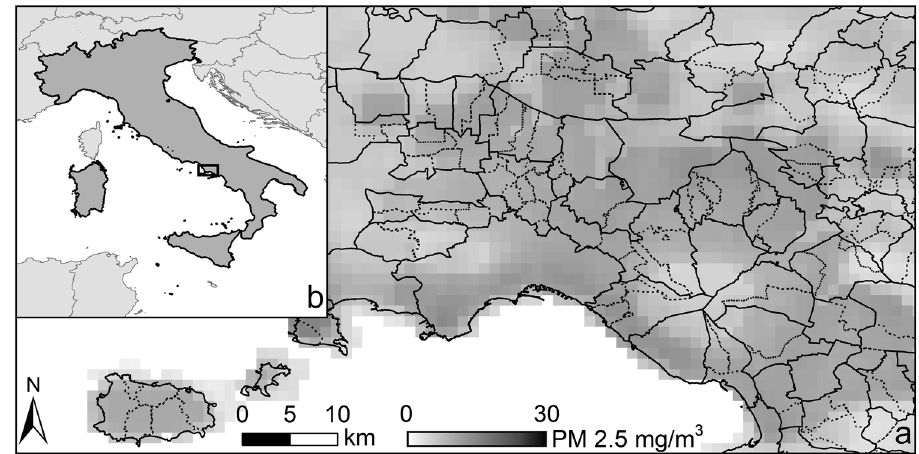
Figure 3. PM2.5 raster layer summarization by Italian communes. ( a ) A detail in the area of Naples allows to observe the impact of ‘smart dissolving’ small communes: the raster grid (grey scale) represents the PM2.5 concentration for each 0.01 degree pixels. The solid line is the results of dissolving the Italian communes using the proposed aggregation approach and by imposing an MMU of 16 km 2 . Dashed line shows the original communes boundaries. ( b ) The location (rectangle) of the area represented with ( a ) in the Italian peninsula. Map produced by the authors using ArcMap (Esri) 10.8